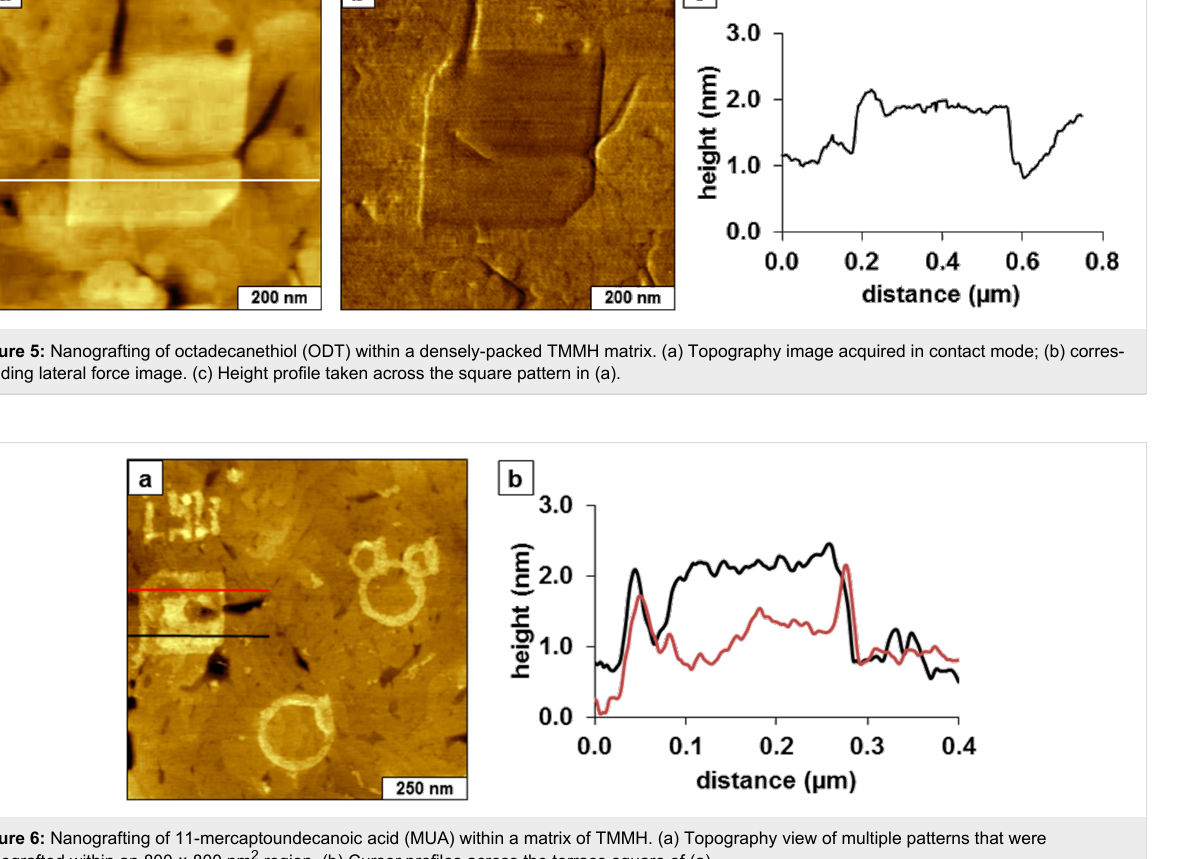
with a double layer (Figure 6b, black line) are 2 ± 0.2 nm taller than the TMMH matrix. Since a double layer of MUA would be 3.0 nm thick, this analysis likewise indicates a height of ~1 nm for the SAM derived from